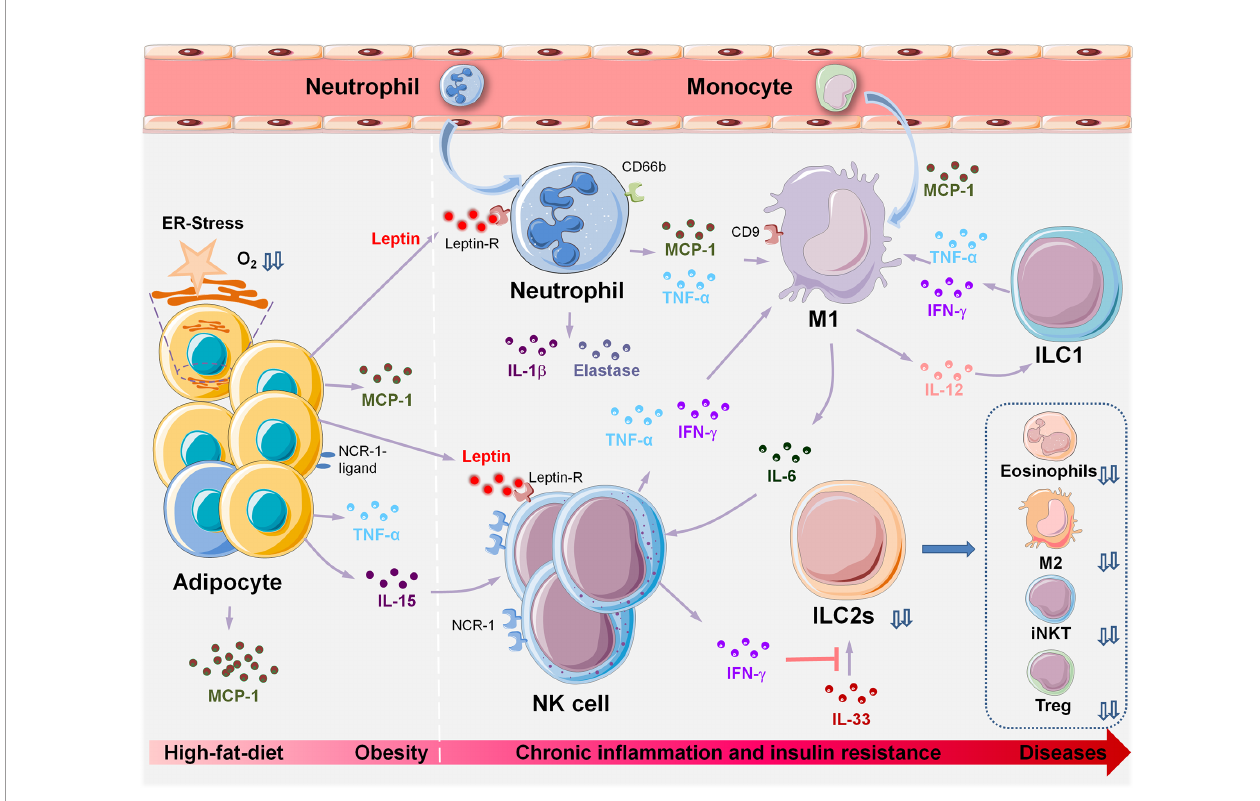
FIGURE 2 | Innate immune cell populations orchestrate metabolic dysfunction in VAT during HFD-induced obesity and associated diseases. HFD-induced obesity leads to adipocyte hypertrophy, pyrolysis, and necrosis. Changes in VAT microenvironment and increased oxygen consumption lead to hypoxia, lipid spillover, and ER stress. Adipocytes and precursor cells produce large amounts of MCP-1 and leptin. MCP-1 induces chemotaxis in a large number of monocytes from peripheral blood, and more than 90% of recruited monocytes locally polarize into M1, which induces and sustains the in fl ammatory state of VAT. Increased levels of leptin are induced by the in fl ammatory cytokine TNF- a . Neutrophils, macrophages, NK cells, and activated T and B cells express leptin receptors on their cell surfaces; hence, leptin may be the initial trigger that causes aggregation of these in fl ammatory cells during obesity, leading to a VAT in fl ammatory response. The following events occur in the following chronological order: peripheral immune cells (neutrophils, NK) are recruited to the local adipose tissue. Obesity induces upregulation of ligands of NCR-1 on the surface of adipocytes and stimulates NK cell proliferation. Next, monocytes are recruited to the local adipose tissue by MCP-1 and differentiate into M1. IFN- g can inhibit the reactivity of ILC2s with IL-33, and the de fi ciency or dysfunction of ILC2s results in insuf fi cient production of IL-4, 5,10,13,33, thus leading to signi fi cant decreases in the number of eosinophils, M2, iNKTs and Tregs. VAT, visceral adipose tissue; HFD, high-fat diet; ER-stress, endoplasmic reticulum stress; MCP-1, monocyte chemotactic protein 1; M1, Type I macrophages; NCR-1, NK cell-activating receptor-1; iNKTs, invariant natural killer T cells; Tregs, regulatory T cells; ILCs, innate lymphoid